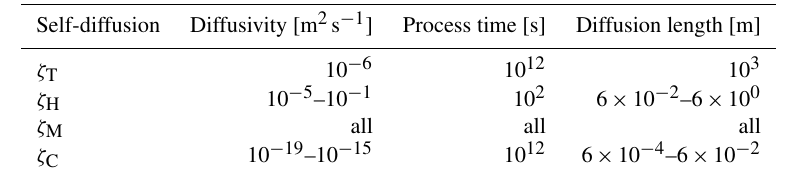
Table A1. Typical diffusion length scales for geological THMC processes (Regenauer-Lieb et al., 2013a). Equation (A1) is used to calculate length scales for a given reaction time. For thermal and chemical processes a geodynamic timescale of 10 12 s is chosen. Geodynamic processes are assumed to cause fluid flow at pore level in less than 100s. Note that the mechanical diffusion length scale can range over all timescales and length scales. As an example, the visco-elastic diffusion length scale for elasto-dynamic earthquake events is very short. However, prior to the catastrophic event stress diffusion can range over all scales and can couple all processes through elasto-visco-plastic creep